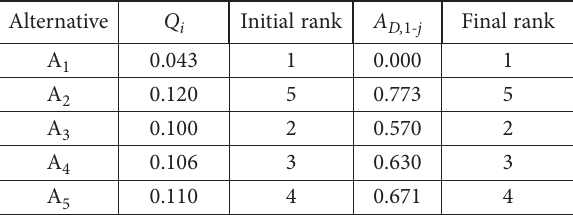
Table 12. The values of the total gaps (Scenario 2)